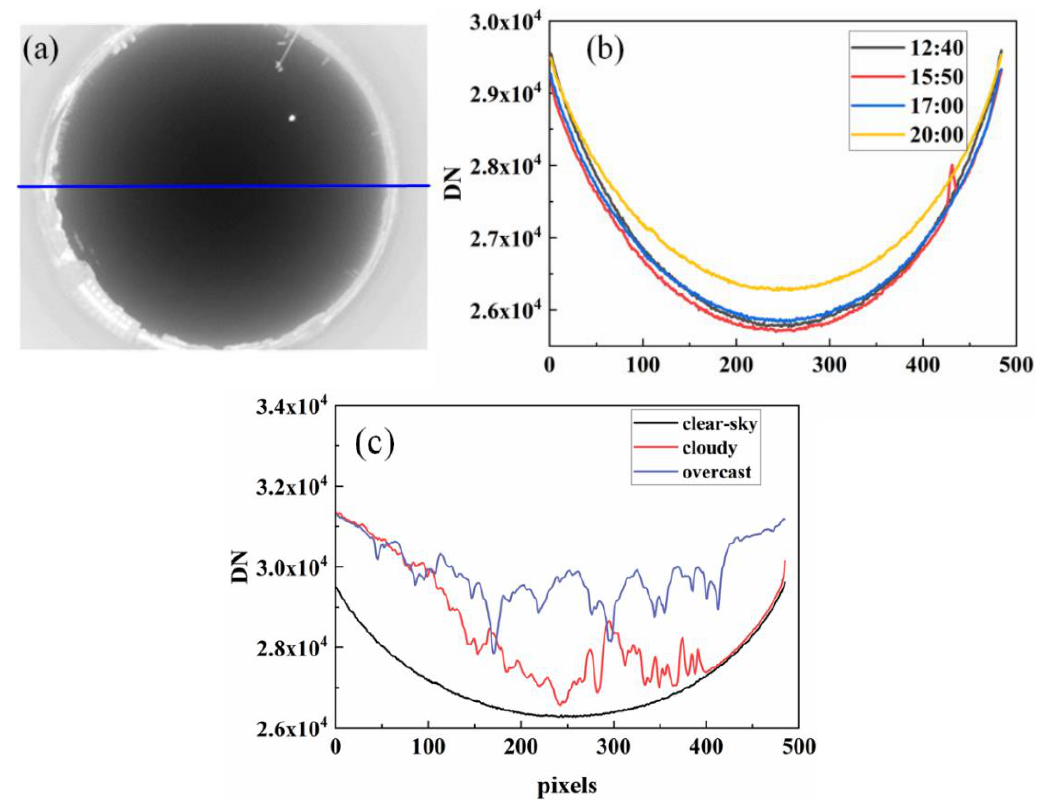
Figure 5. ( a ) Infrared raw clear-sky image, ( b ) measured profiles of the gray value of infrared clear-sky images along one azimuth position at different times on March 12th, 2019, and ( c ) measured profiles of the gray value of infrared images under different sky conditions.